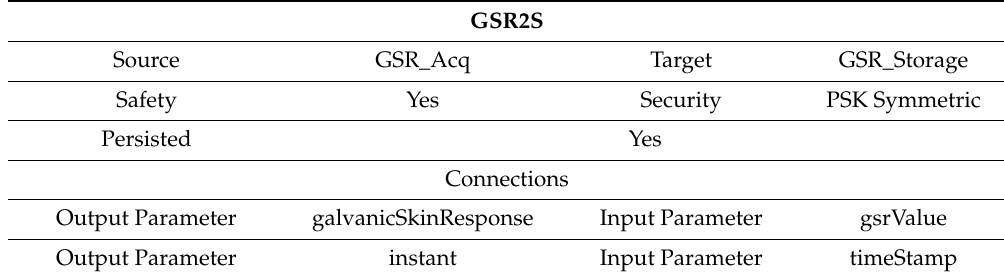
Table 4. Characterization of the GSR2S